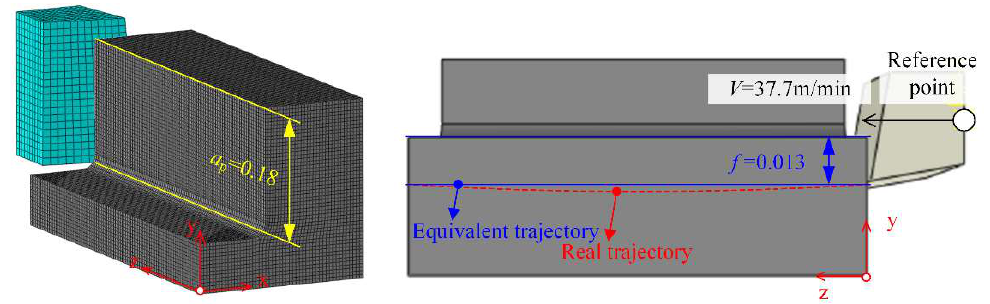
Figure 3. Oblique shear model of the milling process.